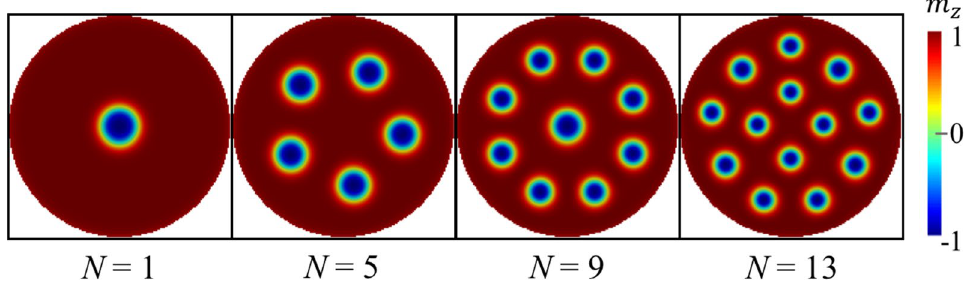
Figure 2. Metastable magnetic states obtained from the minimization energy procedure for the cases N = 1, 5, 9, and 13. The number of skyrmions hosted in the nanodot are a consequence of the magnetic parameters chosen